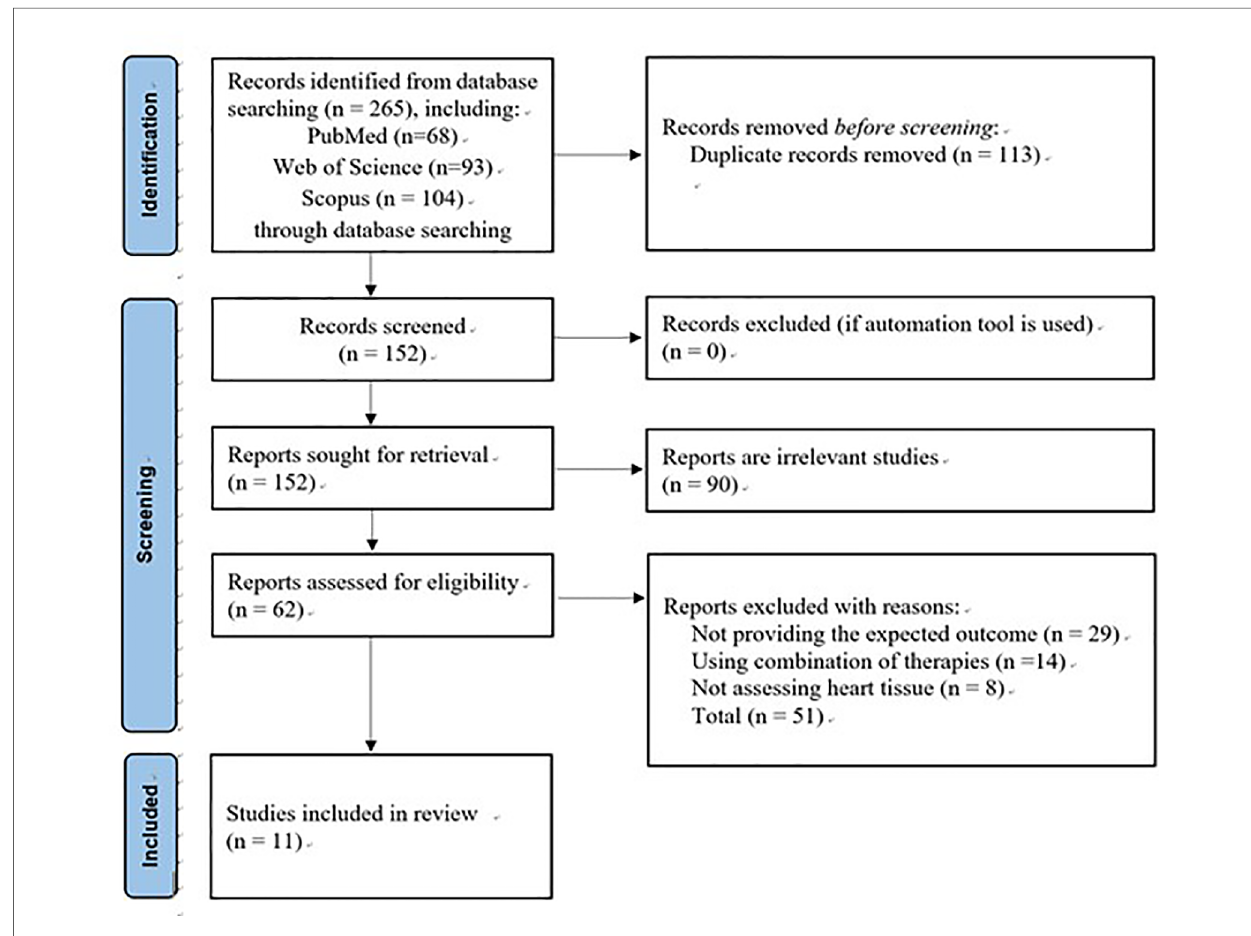
FIGURE 1 PRISMA fl ow diagram (2020) for the selected